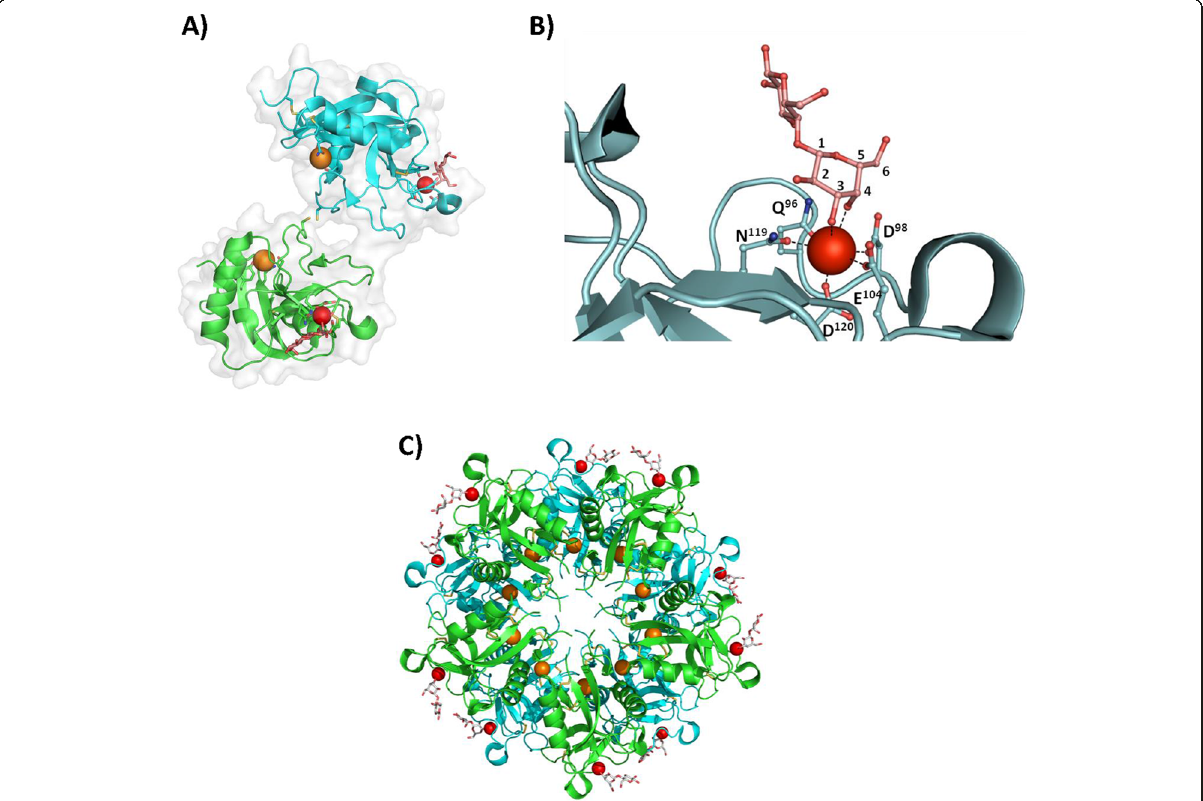
Fig. 2 RSL tertiary structure and carbohydrate binding site. RSL structure as described elsewhere [22]. a A cartoon representation of the RSL dimer complexed with lactose. Cysteine side and inter chains are shown in yellow, calcium and sodium ions are represented as red and orange circles, respectively, and lactose is shown in stick representation colored in red. b Cartoon representation of the carbohydrate-binding site interacting with lactose. c Oligomerization state with the decamer viewed down the pseudo-5-fold rotation axis. The 3D structure illustration was performed using